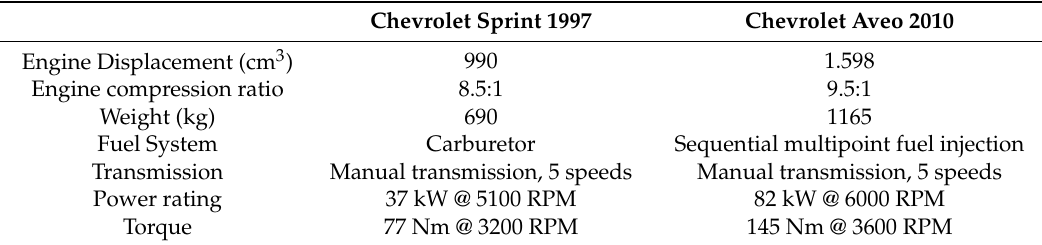
Table 5. Vehicles’ technical characteristics in long-term